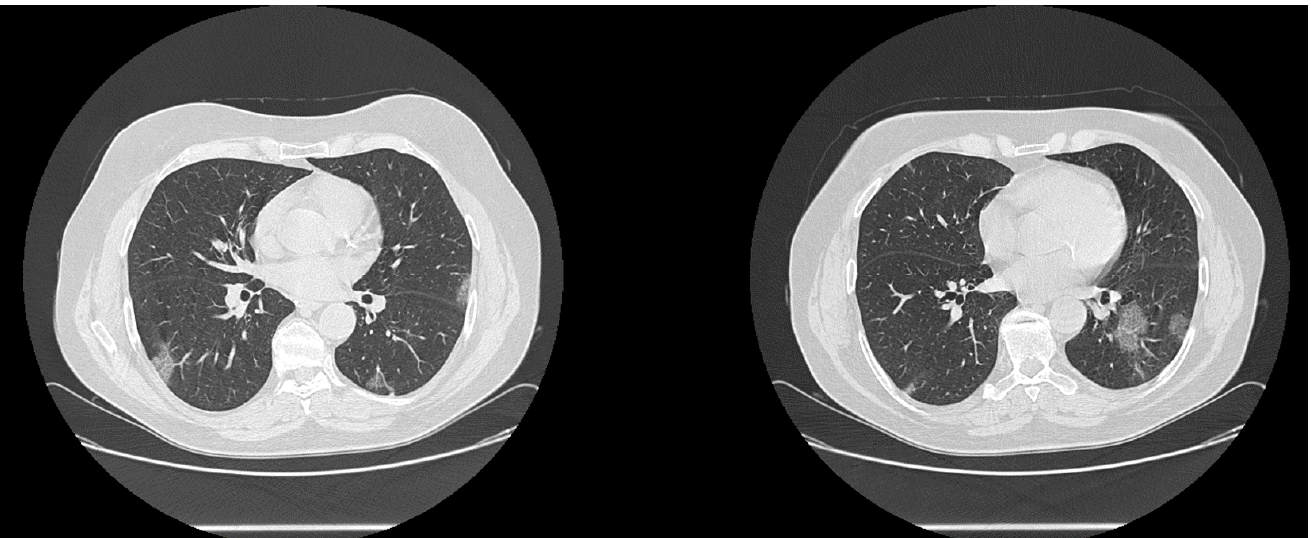
Figure 2. CT examination of a patient with clinical suspicion of COVID-19 infection and negative RT-PCR test. The CT images show the presence of GGO areas with typical roundish morphology and a predominantly peripheral distribution, a suspect picture for COVID-19 infection. The second RT-PCR test showed positive results.